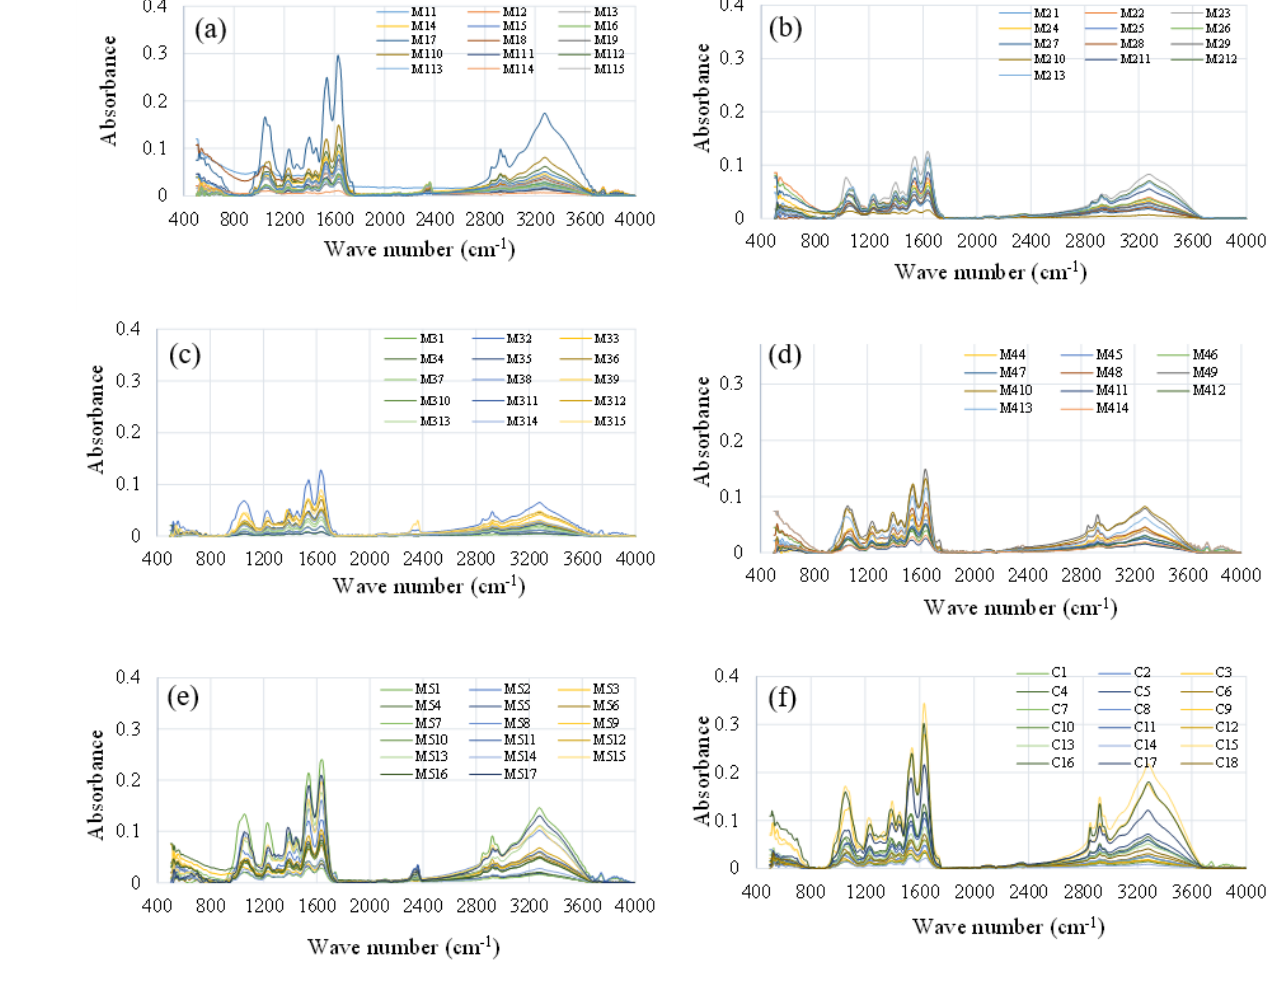
Figure 1: FTIR spectra for bacterial isolates from an unsanitary landfill soil. (a) Conventional NA medium (b) – (f) modified NA medium by adding 40% (M1), 32% (M2), 24% (M3), 16% (M4), 8% (M5) (v/v) of soil extract obtained from the landfill